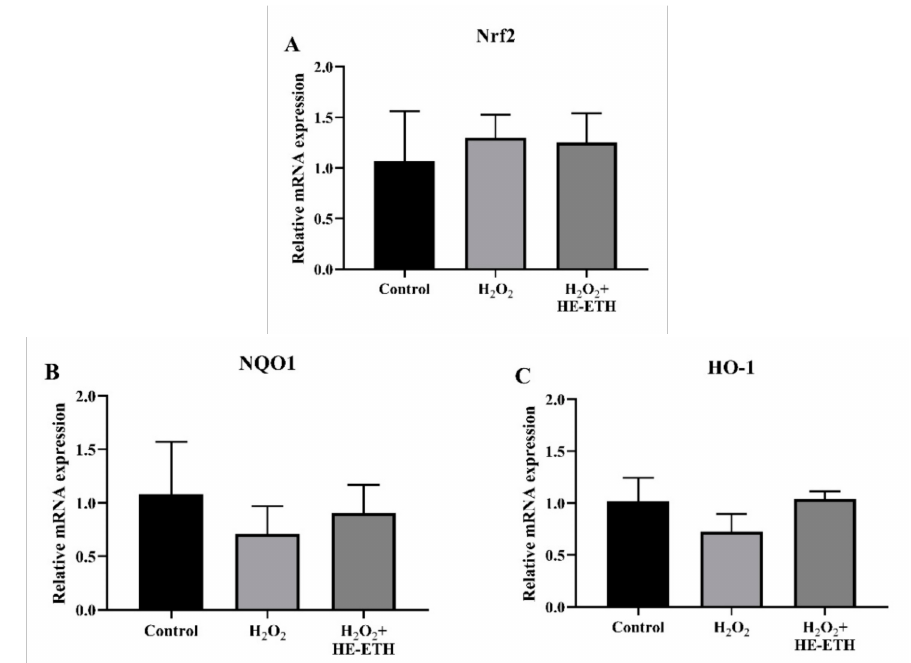
Figure 8. Analysis of transcriptional expression measured by qPCR. HT22 was co-incubated with 250 µ M H µ g / mL ethanolic extract (HE-ETH) before subjected to qPCR for quantification of ( A ) 2 O 2 and 400 nuclear factor erythroid 2-related factor 2 (Nrf2), ( B ) NAD(P)H quinone dehydrogenase 1 (NQO1) and ( C ) heme oxygenase-1 (HO-1) mRNA expression. All values presented correspond to mean ± SD of triplicates ( n =